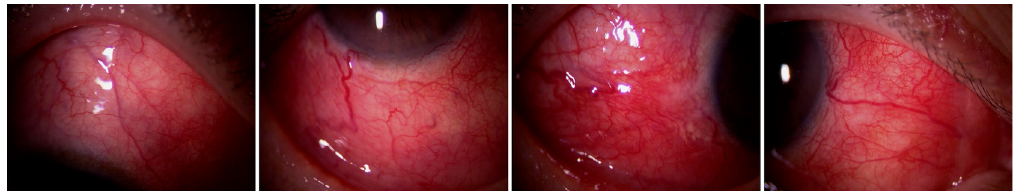
Figure 1. Diffuse anterior scleritis associated with RPC.